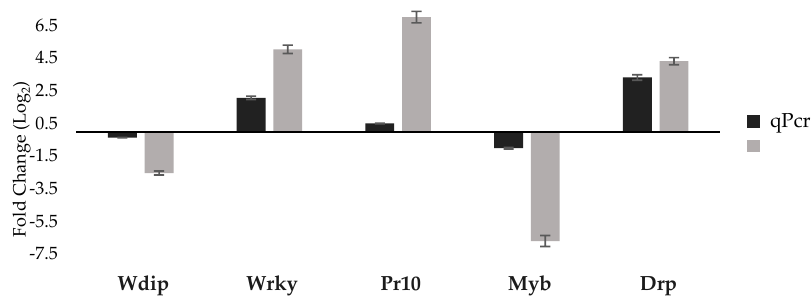
Figure 2. Fold Change for each of the transcripts selected for validation. The values are represented as the Log2 of the normalized expression value of both RNA-Seq and qPCR data, at time point Pp04.